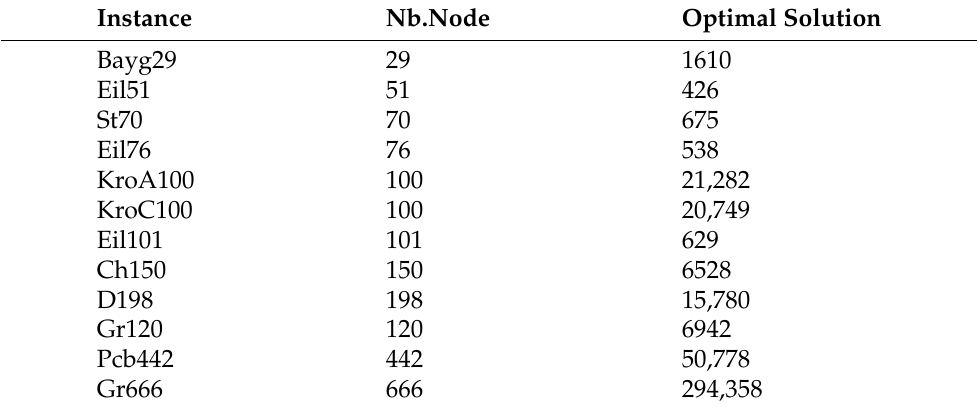
Table 1. Data sets used for testing.